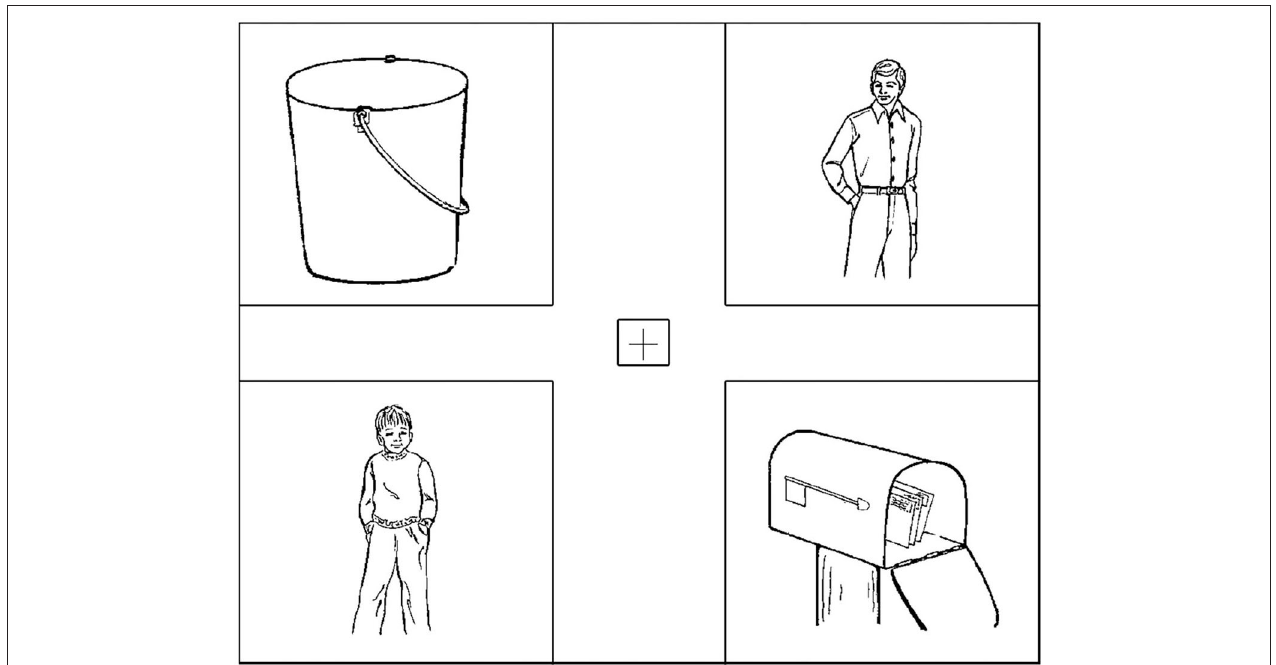
FIGURE 2 | Display of the trial corresponding to (14a), Experiment